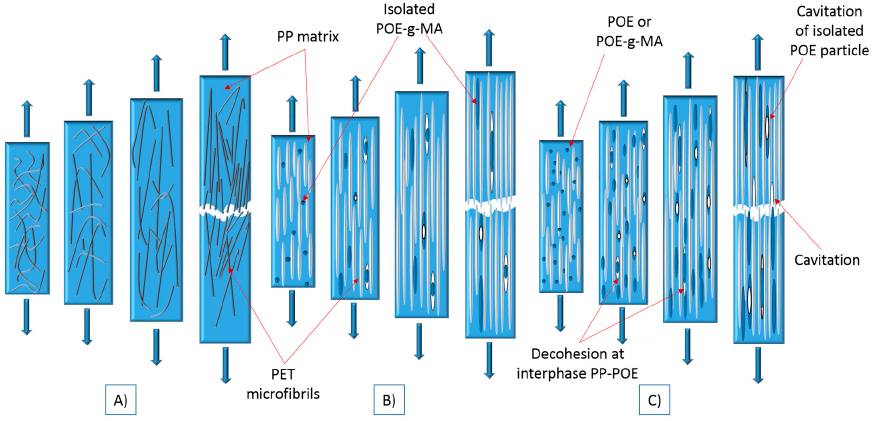
Figure 6. Tensile fracture model: ( A ) Case MFC; ( B ) POE- g -MA EXT ; ( C ) Case POE EXT , POE IM or POE- g -MA IM .